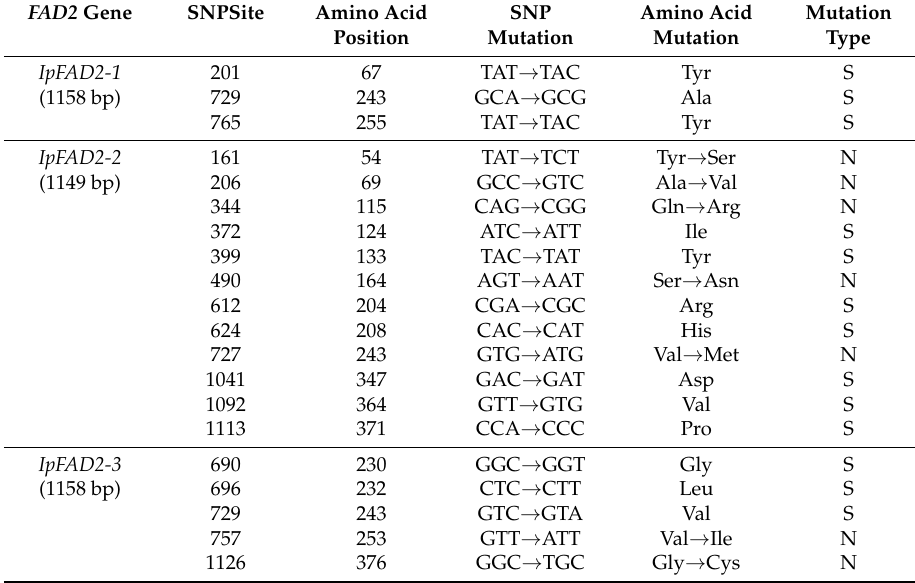
Table 1. Single nucleotide polymorphisms (SNPs) in the coding region of fatty acid desaturase 2 ( FAD2 ) genes from Idesia ploycarpa